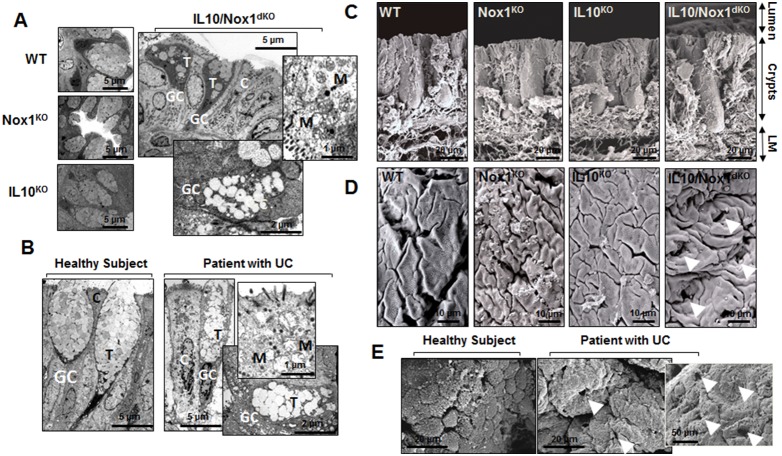
Similar ultrastructural abnormalities in the colonic epithelium of IL10/Nox1dKO mice and patients with UC.(A) Representative transmission electron micrographs of the unaffected colon of 4-week old WT (n = 5), Nox1KO (n = 5), IL10KO (n = 10), and IL10/Nox1dKO (n = 10) mice. (B) Representative transmission electron micrographs of the unaffected colon of 10 healthy subjects and 10 patients with UC. Note that IL10/Nox1dKO mice display morphological goblet cell abnormalities similar to those found in patients with UC including reduced size of thecae containing stored mucins, immature mucus granules, and swollen mitochondria. (C) Representative scanning electron micrographs (SEM) of distal colonic crypts of 6-week old WT (n = 5), Nox1KO (n = 5), IL10KO (n = 10), and IL10/Nox1dKO (n = 10) mice. Note that the Lieberkhün’s crypts are longer in IL10/Nox1dKO mice. (D) Representative scanning electron micrographs of the distal colonic epithelium of 6-week old WT (n = 5), Nox1KO (n = 5), IL10KO (n = 8), and IL10/Nox1dKO (n = 10) mice. Note the inappropriate pattern of crypt openings (arrowheads) on SEM with enlarged extrusive zones and dilated gland lumen in the distal colon of IL10/Nox1dKO mice. (E) Representative SEM of the unaffected colonic mucosa of 10 healthy subjects and 10 patients with UC. Note the regular pattern of crypt openings with diffuse edema, enlarged extrusive zones, and dilated gland lumen similar to those found in IL10/Nox1dKO mice. Abbreviations: GC: goblet cell, C: colonocyte, T: thecae, LM: lamina propria, M: mitochondria.